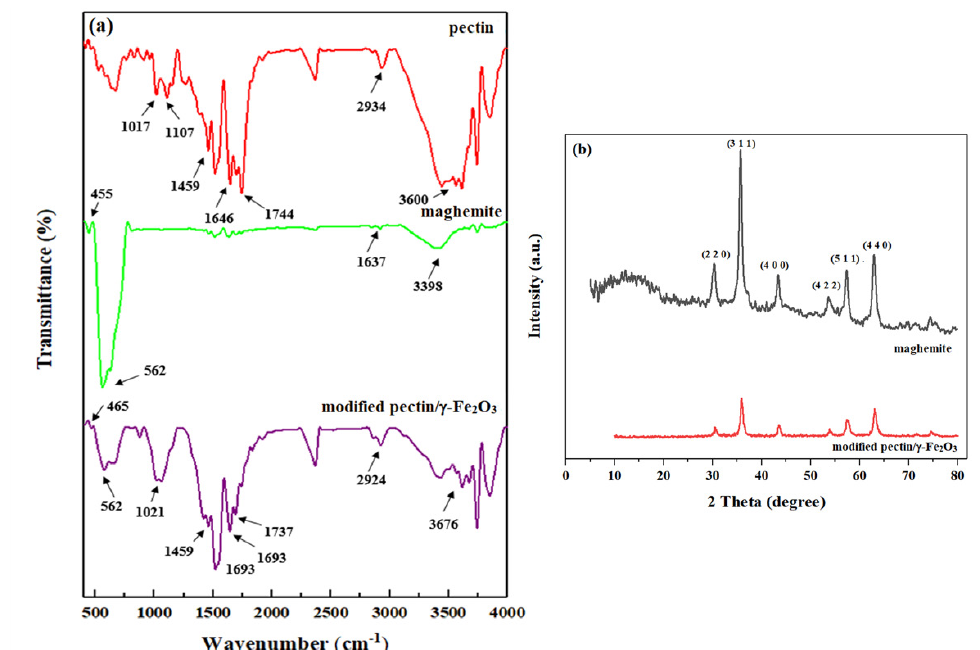
Fig. 1. (a) FTIR spectra of pectin, maghemite nanoparticles, and pectin/ γ -Fe